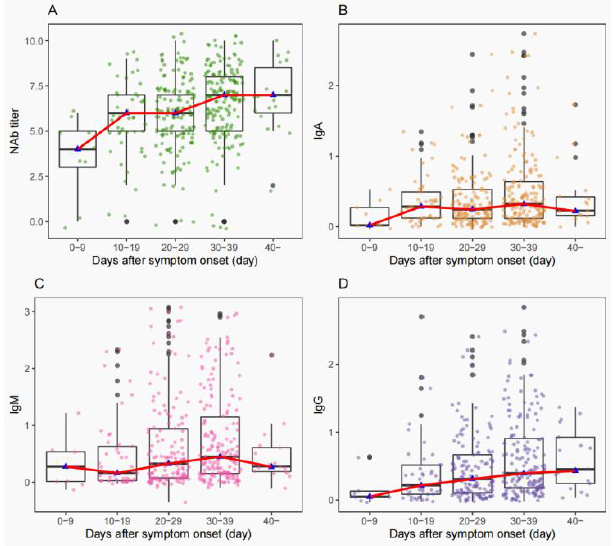
Figure 2. Distribution of titers of neutralization antibody (NAb)/IgA/IgM/IgG with days after symptom onset. The green circles represent the NAb titer, the yellow circles represent the IgA, the red circles represent IgM, and the purple circles represent the IgG. Each circle represents one sample: ( A ) micro-neutralization assay Nab; ( B ) enzyme-linked immunoassay IgA; ( C ) enzyme-linked immunoassay IgM; ( D ) enzyme-linked immunoassay